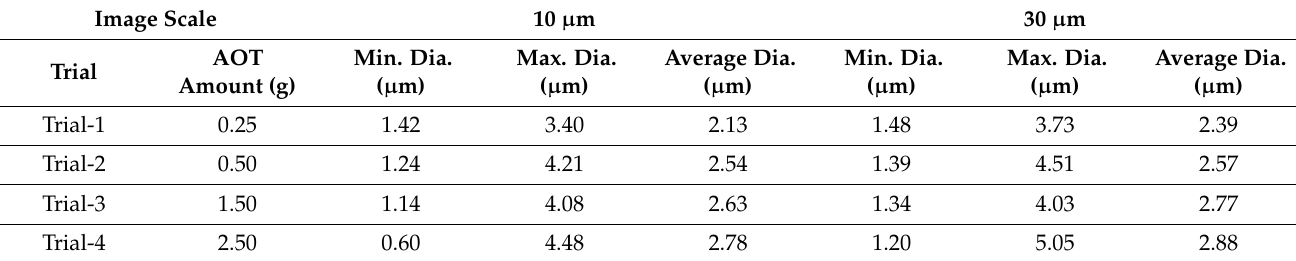
Figure 5. Trial-4 (2.50 g AOT) microcapsule SEM images for scales of ( a ) 10 µm and ( b ) 30 µm. Table 2. Microcapsule minimum, maximum, and average diameters at different image